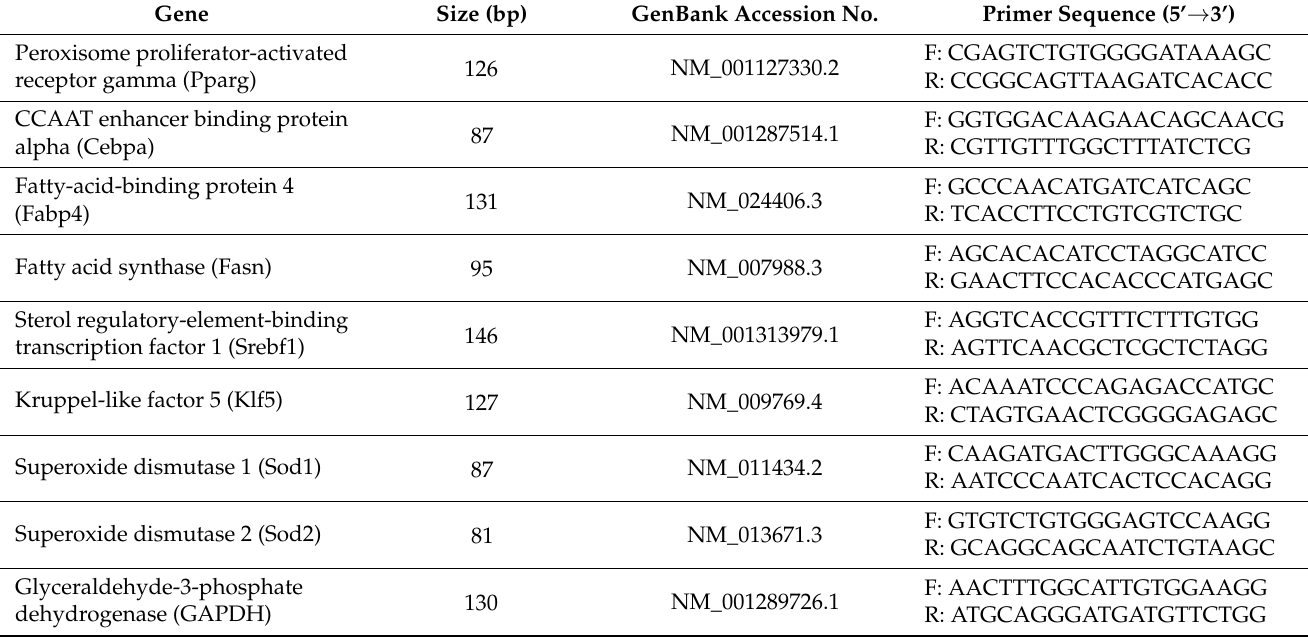
Table 2. The primers we used in